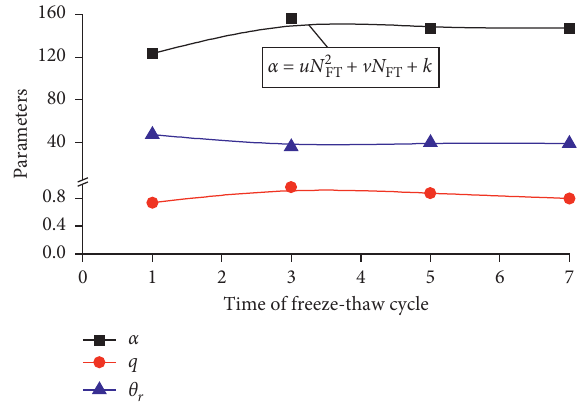
Figure 16: Relationships between parameters of the Gardner model and the time of freeze-thaw